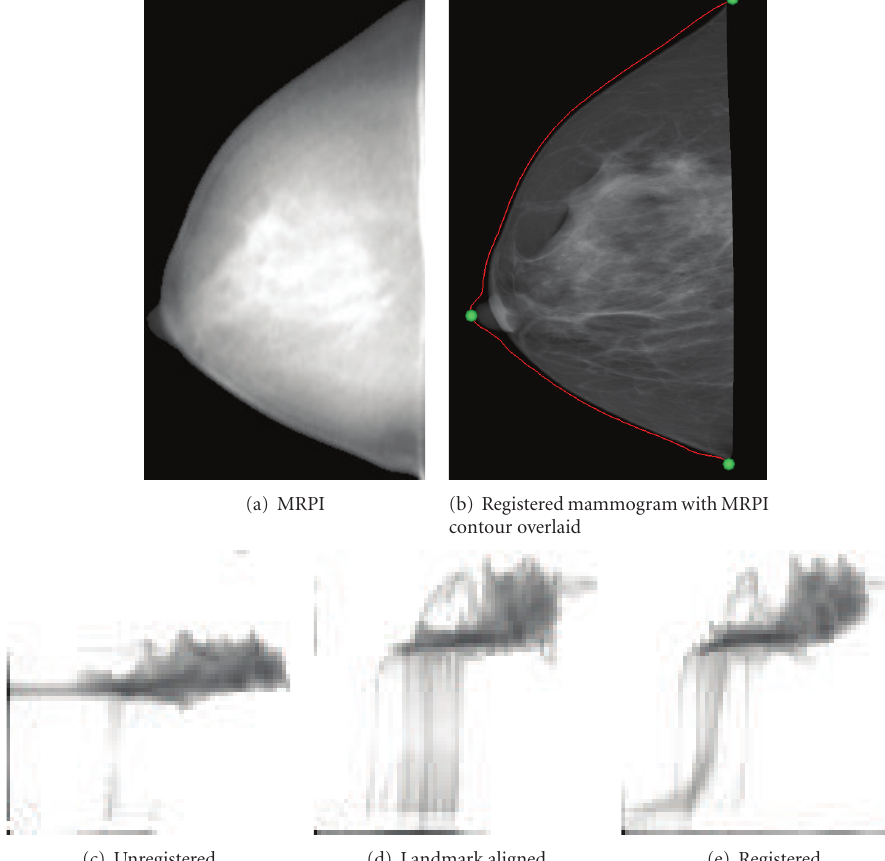
Figure 13: The data set with the highest Dice’s coe ffi cient value and most coherent entropy plot, objectively the best alignment (100923-R-